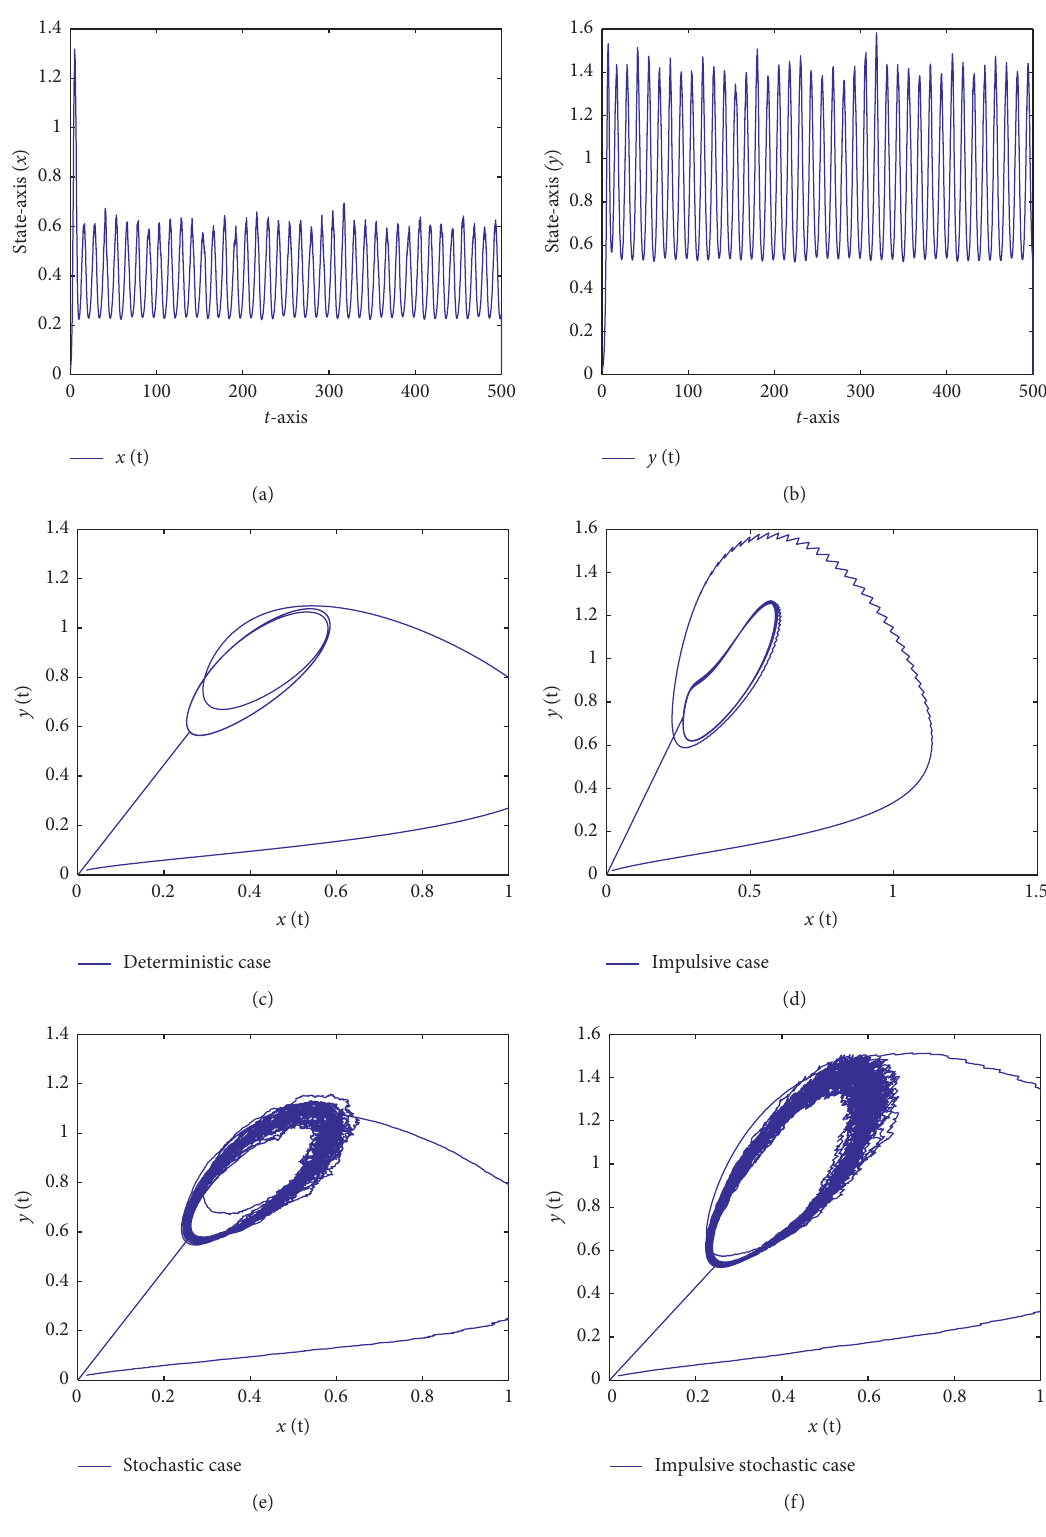
Figure 1: Periodic Markov process of (5) with n � 1 and x ( 0 ) � y ( 0 ) � 0 . 02. (a) The time series graph of x . (b) The time series graph of y . (c) The phase graph of deterministic system ( ξ ik � 0 , σ i ( t ) � 0 , i � 1 , 2 ) . (d) The phase graph of impulsive system ( σ i ( t ) � 0 ,i � 1 , 2 ) . (e) The phase graph of stochastic system ( σ i ( t ) � 0 ,i � 1 , 2 ) . (f) The phase graph of stochastic impulsive system with ( t ) � 0 . 02 + 0 . 02 sin ( t /2 ) , σ ( t ) � 0 . 01 + 0 . 01 sin ( t /2 ) , ξ � 0 . 01 + 0 . 01 sin ( t /2 ) , ξ � 0 . 01 + 0 . 01 sin ( t /2 ) , t � 0 . 1 k,k ∈ N σ k 1 2 1 k 2 k